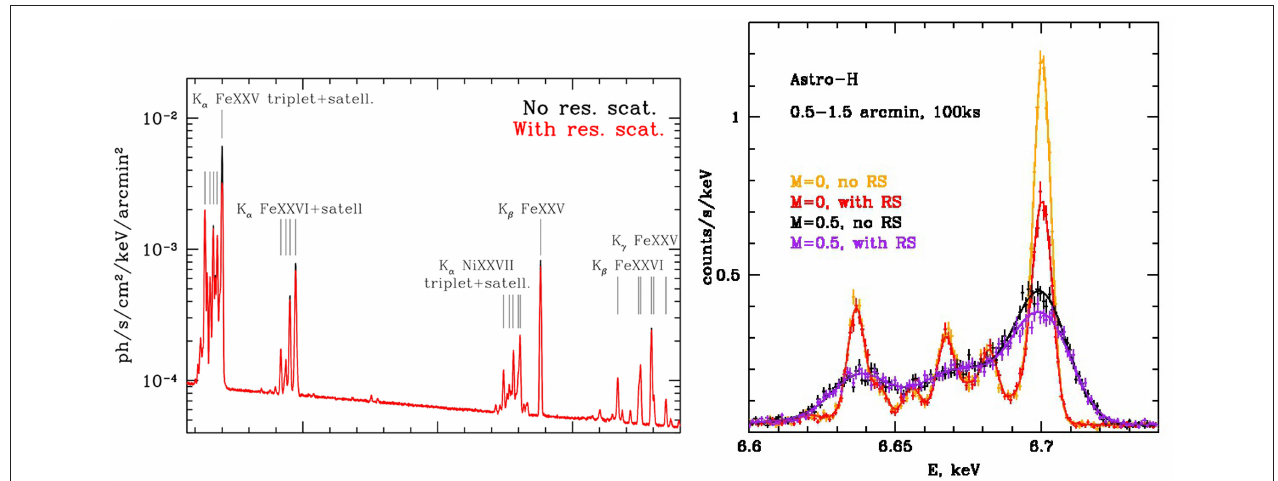
FIGURE 3 | Left panel: Simulated spectrum around the Fe xxv line complex for the Perseus cluster with and without resonant scattering (black and red lines; the red lines cover most of the emission lines; Figure 4a from Zhuravleva et al., 2013). Right panel: Simulated spectra of an Astro-H observation of 100ks of the core region of the Perseus Cluster (data points; from Zhuravleva et al., 2013). The solid lines represent theoretical model spectra with (red and magenta lines) and without (yellow and black lines) resonant line scattering and with (black and magenta lines) and without (yellow and red lines)